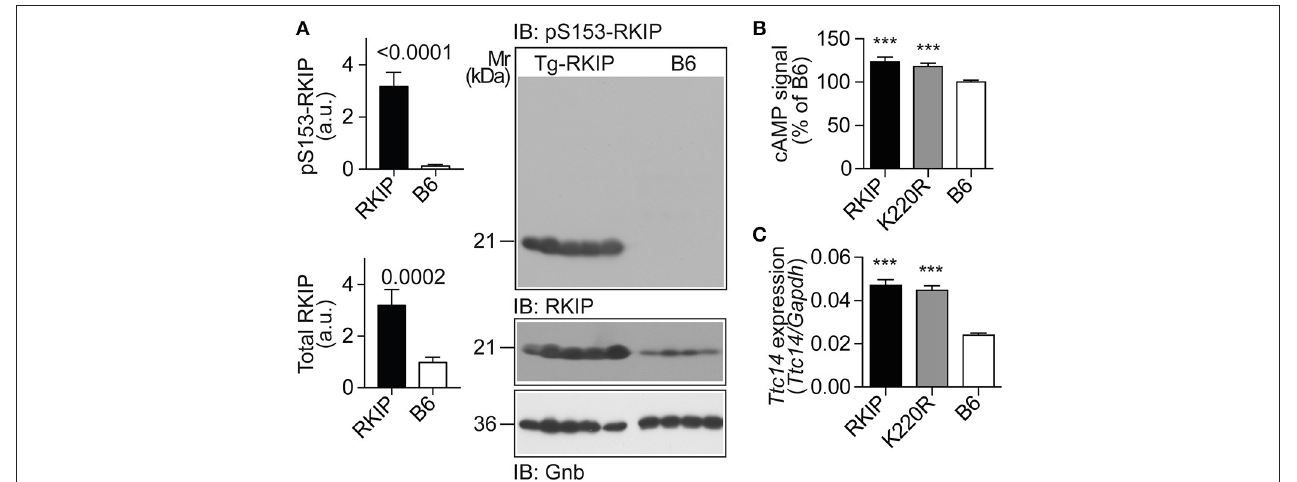
FIGURE 9 | RKIP and GRK2-K220R act as GRK2 inhibitors in vivo . (A) Immunoblot detection of RKIP phosphorylation on serine-153 and total cardiac RKIP content in 8-months-old Tg-RKIP compared to non-transgenic B6 hearts ( ± s.d.; n = 5 Tg-RKIP; n = 4, B6). (B,C) Sensitization of the isoproterenol-stimulated cAMP response in neonatal cardiomyocytes isolated from Tg-RKIP and Tg-GRK2K220R mice compared to non-transgenic B6 cardiomyocytes (B) , and increased cardiac expression of the cAMP-inducible gene, Ttc14, in Tg-RKIP, and Tg-GRK2K220R hearts (C) . Data represent mean ± s.d. ( n = 6, B ; n = 3, C ; *** p < 0.001 vs. B6; Dunnett’s test). See also Supplementary Figure 8 .